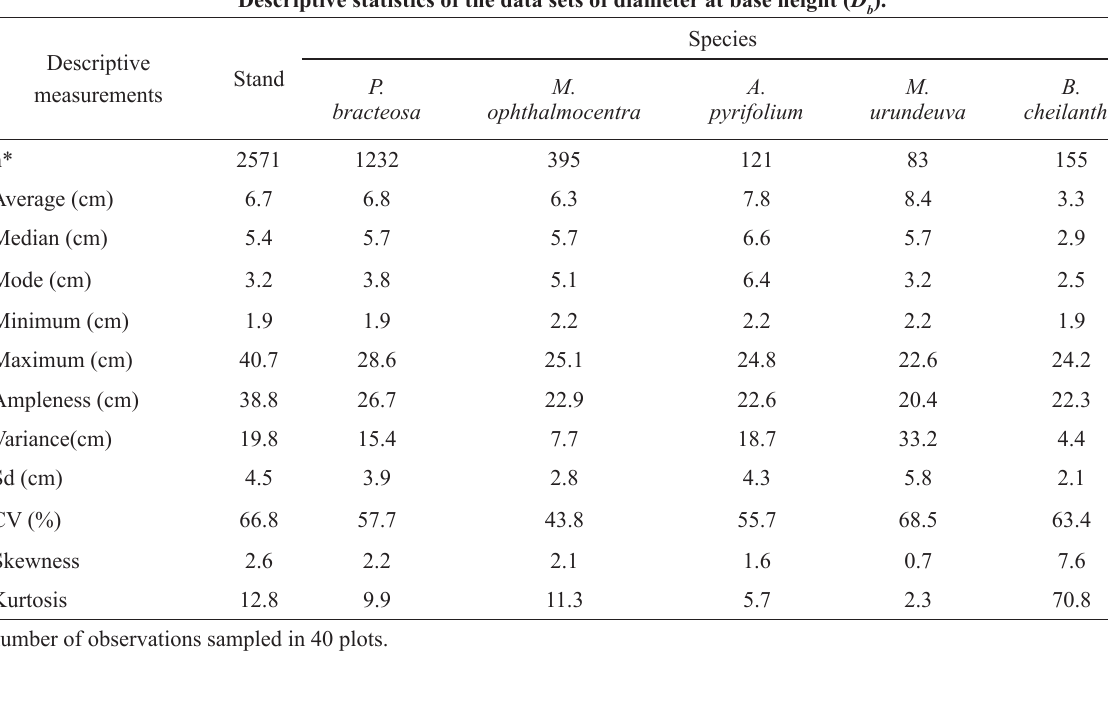
Descriptive statistics of the data sets of diameter at base height ( D